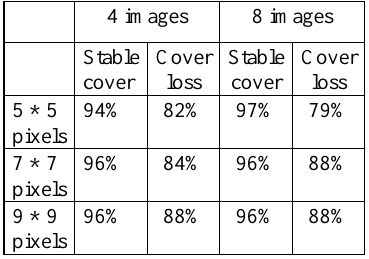
Table 2a . Accuracies of the models depending on patch sizes and pre-change data time series sizes.